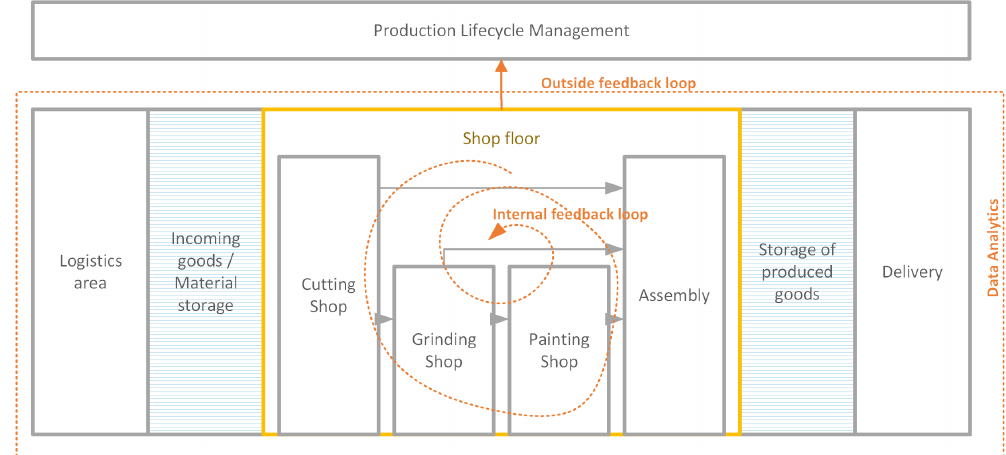
Figure 1. Smart factory areas.